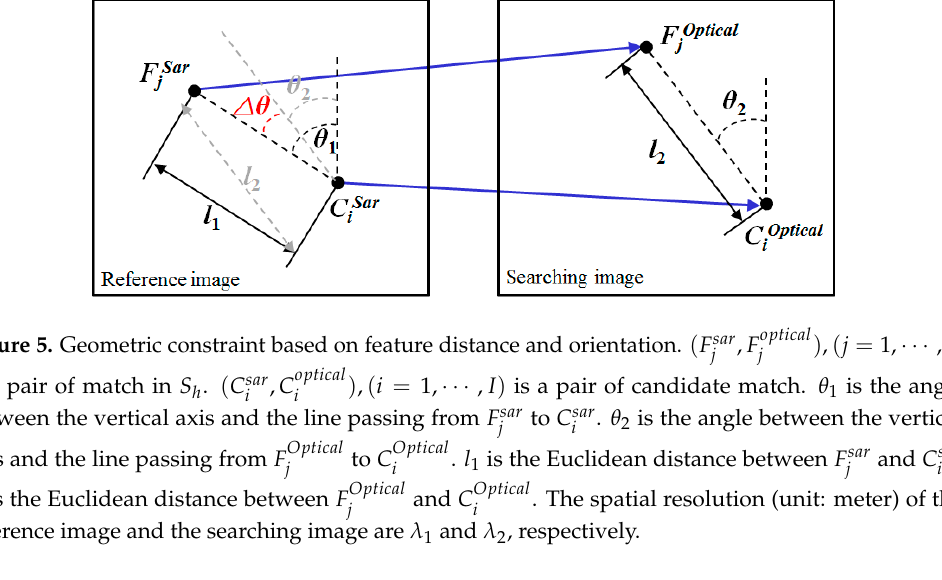
F F j J =  is a ) , ( j = 1, · · · , J ) , F optical j j j j θ is the angle between the S . ( , ),( 1, , ) sar optical C C i I =  is a pair of candidate match. ) , ( i = 1, · · · , I ) is a pair of candidate match. θ h 1 , C optical i i 1 is the angle i i θ is the angle between the vertical axis and F to sar C . to C sar . θ 2 is the angle between the vertical 2 j i j i l is the Euclidean distance between sar l is F to Optical F and sar C . C . to C Optical . l 1 is the Euclidean distance between F sar and C sar . 1 2 j j i i j i j i F and Optical C . The spatial resolution (unit: meter) of the and C Optical . The spatial resolution (unit: meter) of the j i j i λ and λ , respectively. 1 2